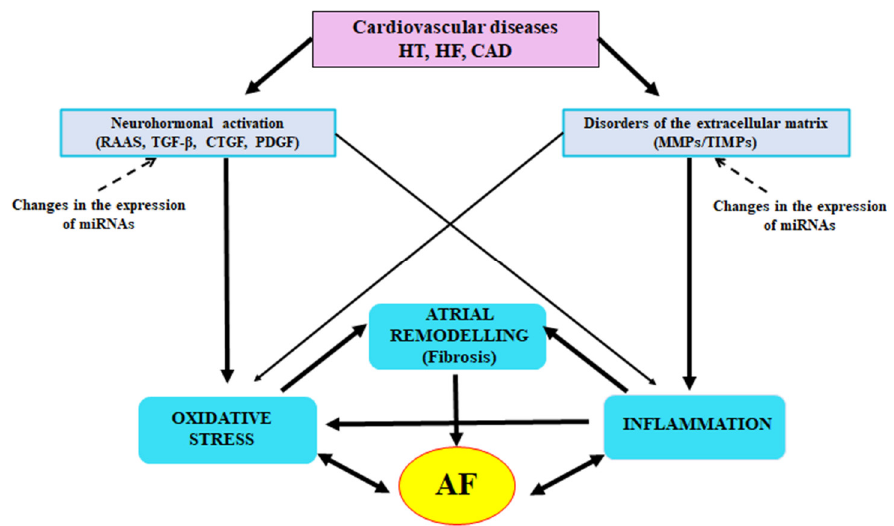
Figure 4. Possible association of atrial fibrillation with atrial remodelling, inflammation and oxida- tive stress. ⤏ modulation of the expression; → activation of the expression. AF—atrial fibrillation; CAD—coronary artery disease; HF—heart failure; HT—hypertension; PDGF—platelet-derived growth factor; RAAS—renin-angiotensin-aldosterone system; TIMP—tissue inhibitor of metallo- proteinase.